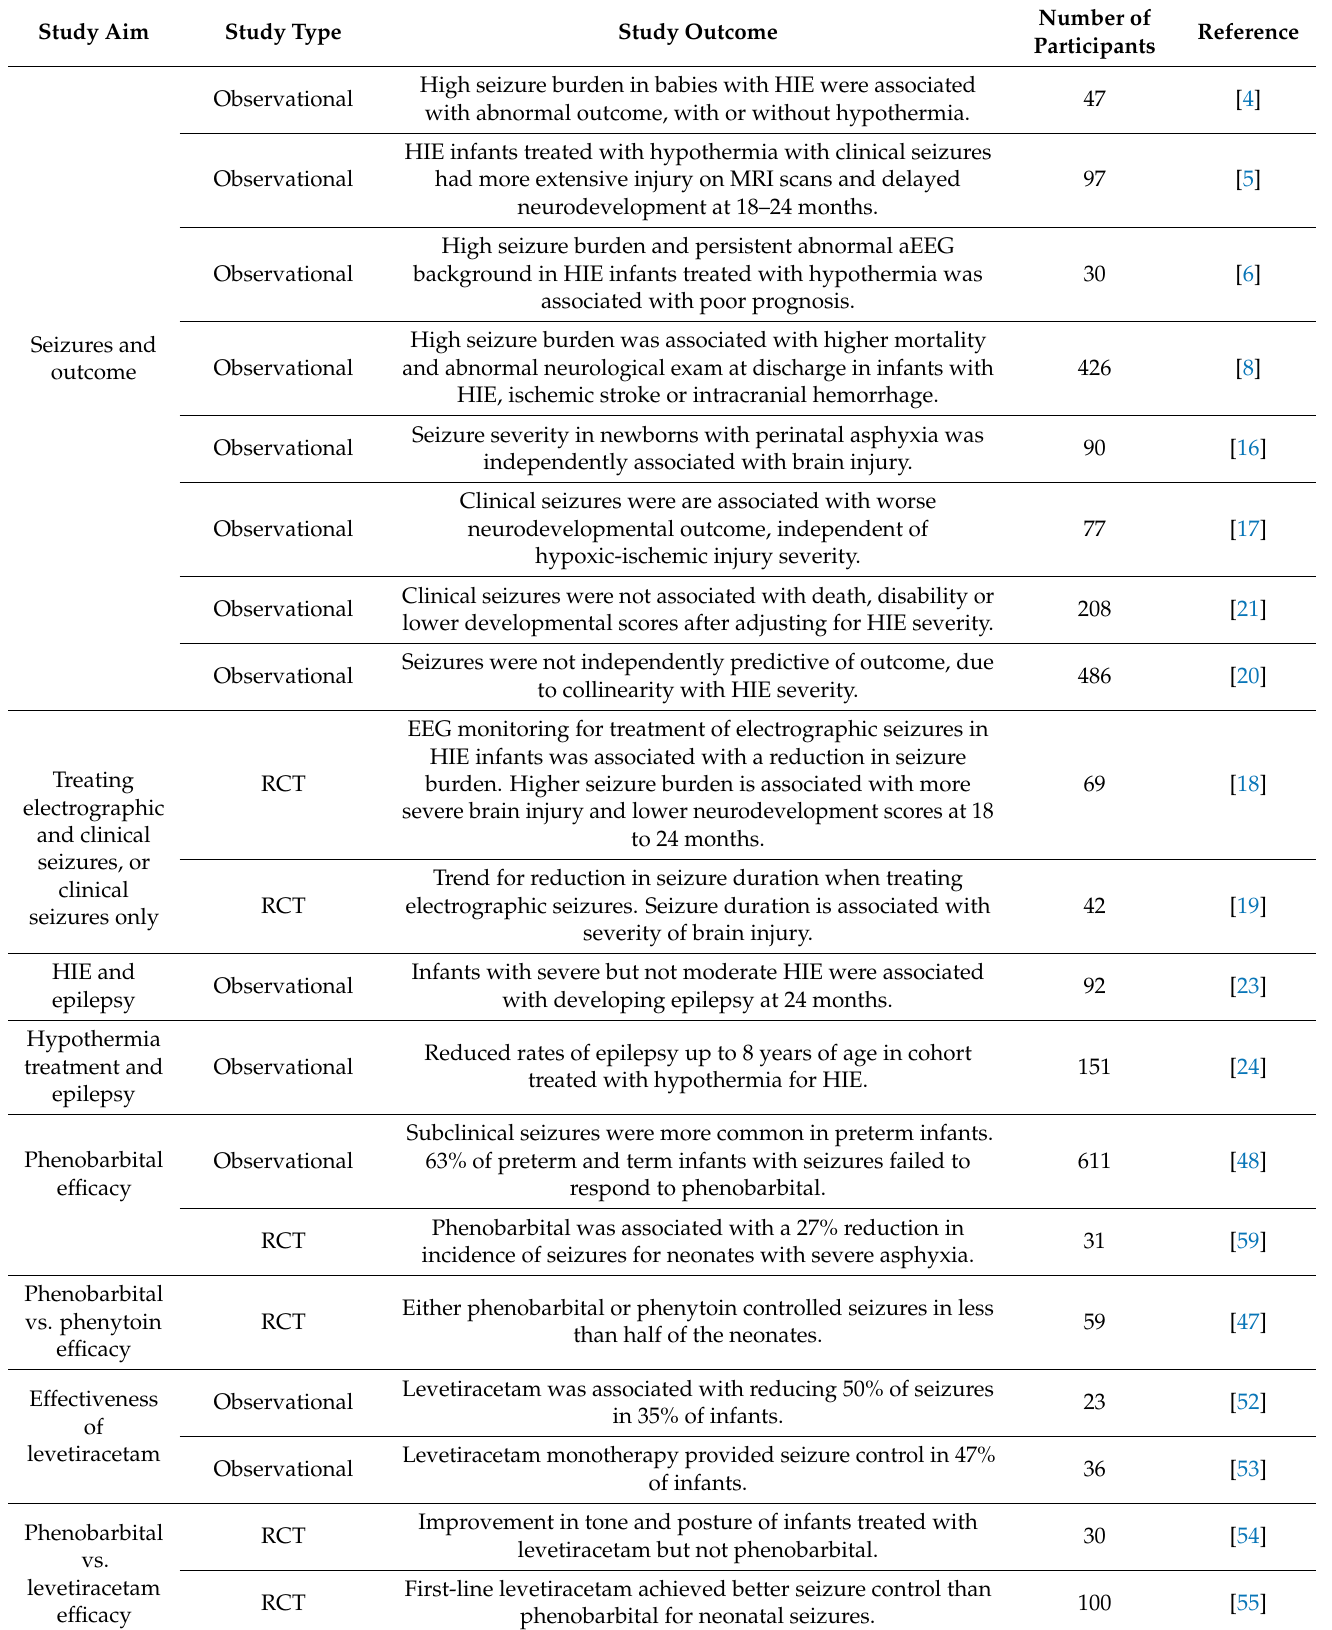
Table 2. Summary of clinical studies of anticonvulsant